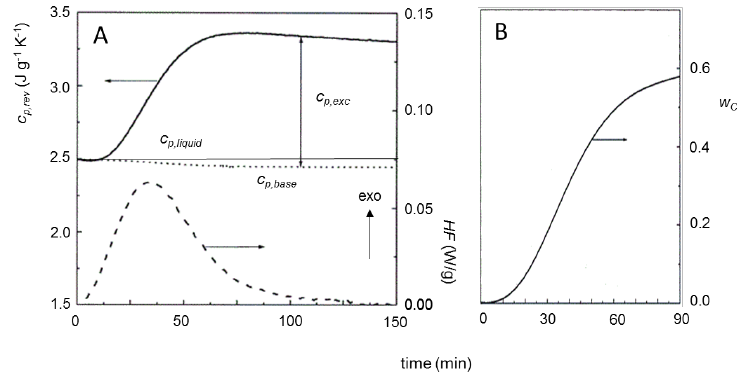
Figure 10. ( A ) Reversing specific heat capacity ( c p,rev ) of a linear polyethylene (PE) during quasi-